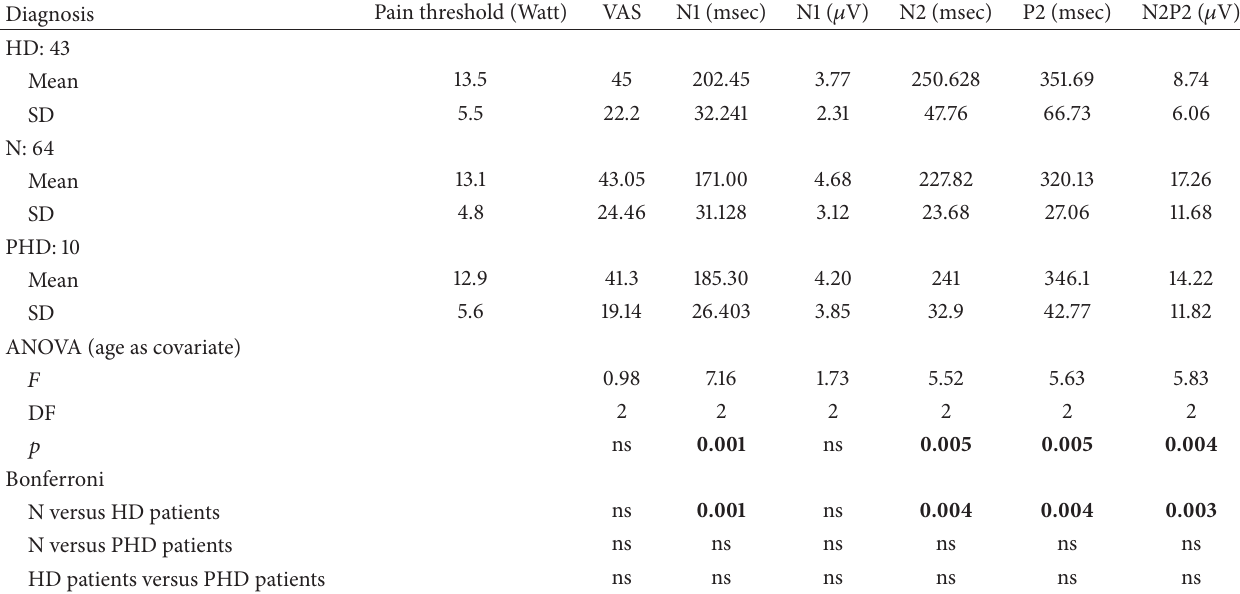
Table 2: Laser evoked potentials features, including laser pain threshold and subjective perception (expressed by visual analog scale (VAS) from 0 to 100) in Huntington’s disease (HD) subjects, presymptomatic Huntington’s disease (PHD) subjects, and normal controls (N). The results of one-way ANOVA and post hoc Bonferroni test are reported. Significant results are reported in bold font.